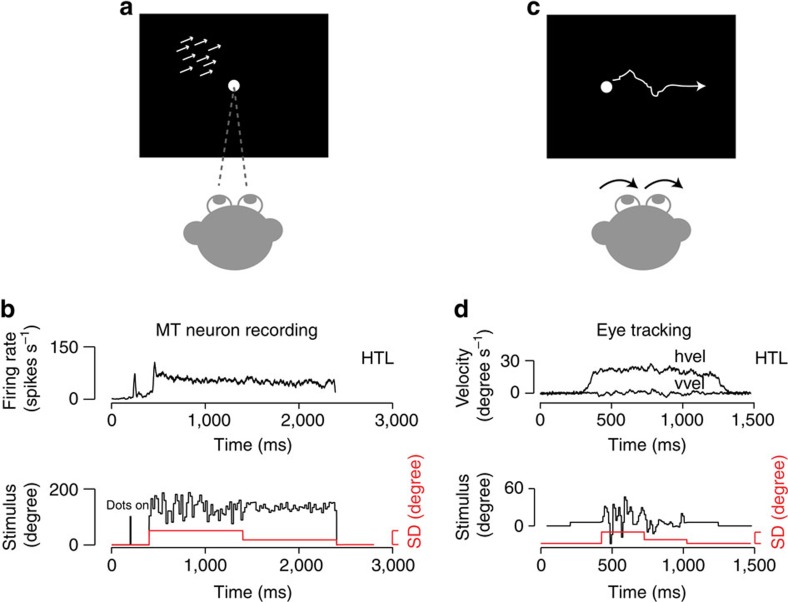
Experimental design and example data.(a) A fixation task kept motion stimuli centred on the receptive field. (b) Lower panel: stimuli had a constant drift speed and a mean direction chosen to fall on a flank of neuron's direction tuning curve. We added a stochastic direction perturbation, updated every 20 ms (black) that shifted from HTL (or LTH, not shown) variance during the trial (red). Upper panel: PSTH of an isolated MT neuron. (c) Pursuit task design. Targets translated across the screen with identical direction statistics as for a but in a randomly selected mean direction to minimize anticipation. (d) Upper panel: Horizontal and vertical components of eye velocity during a single trial with a HTL variance shift. Lower panel: target direction (black) or direction variance (red) over time.